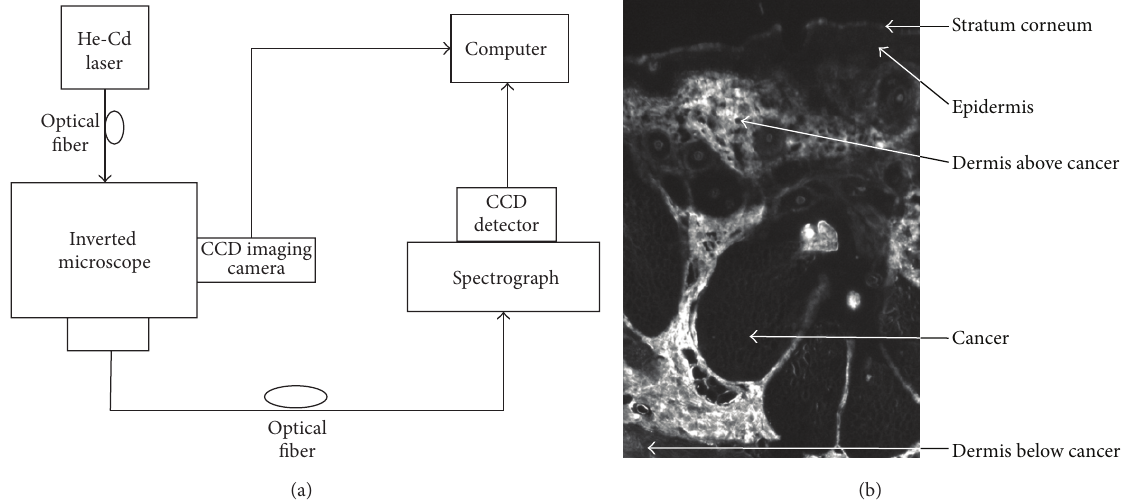
Figure 1: (a) The system setup of MSP system. (b) The fluorescence spectra of different skin layers measured from a 16 𝜇 m unstained BCC tissue section at 442nm